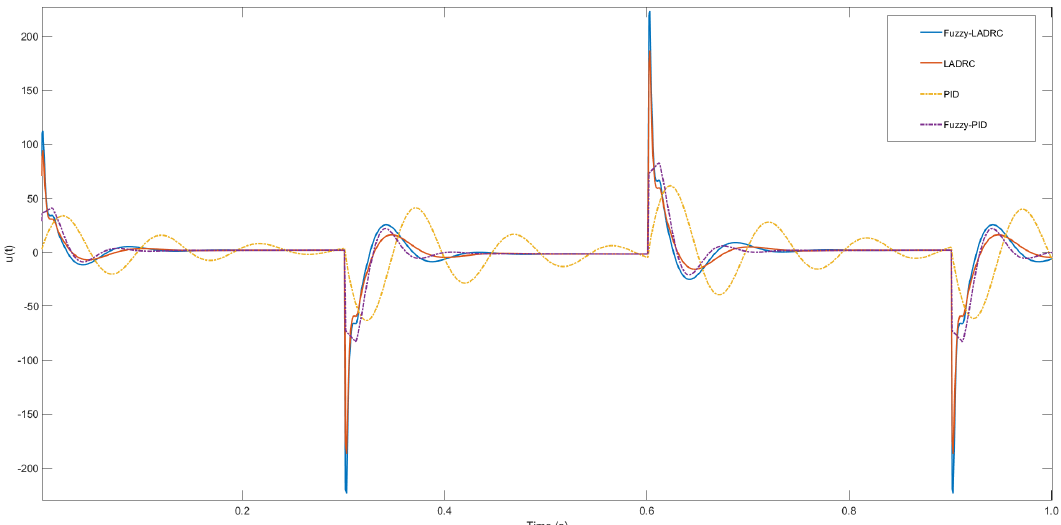
Figure 11. Controller inputs of X-channel when tracking triangle wave signal.